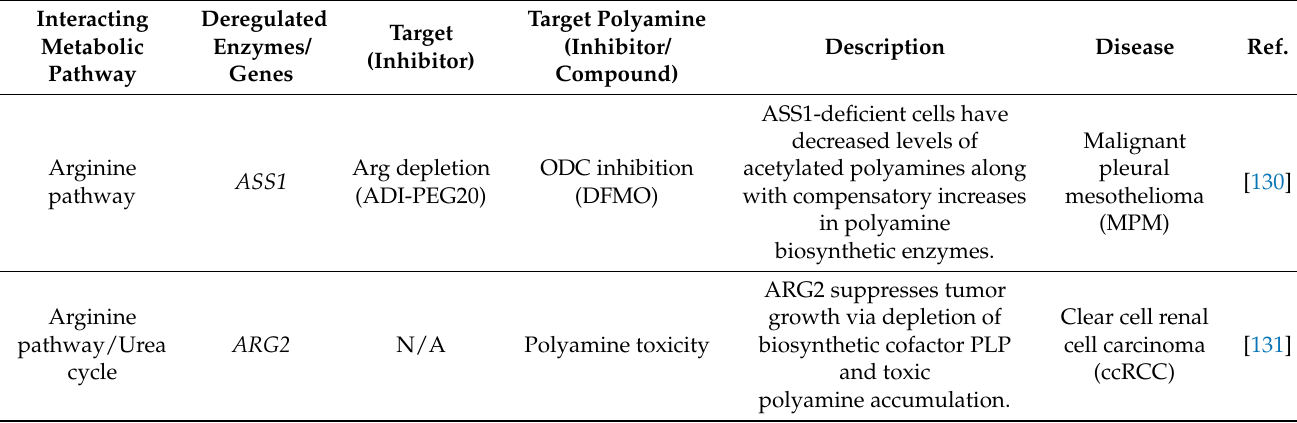
Table 1. Polyamine metabolic vulnerabilities in cancer and other